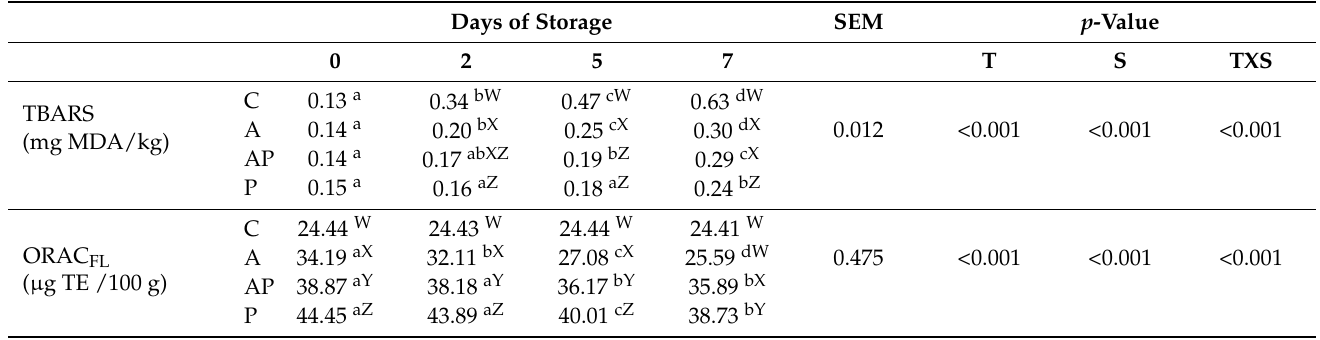
Table 2. Lipid oxidation (TBAR S ) and antioxidant capacity (ORAC FL ) in beef burger during storage. Days of Storage SEM p